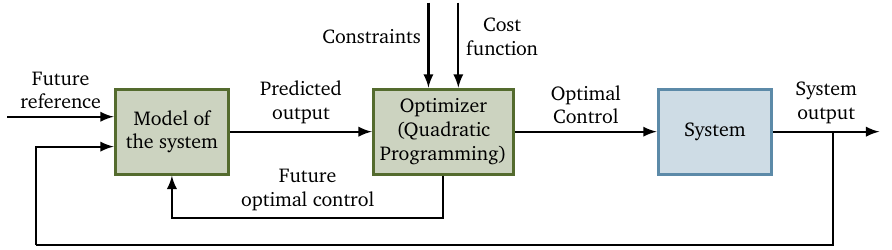
Figure 5. Layout of the nonlinear model predictive control